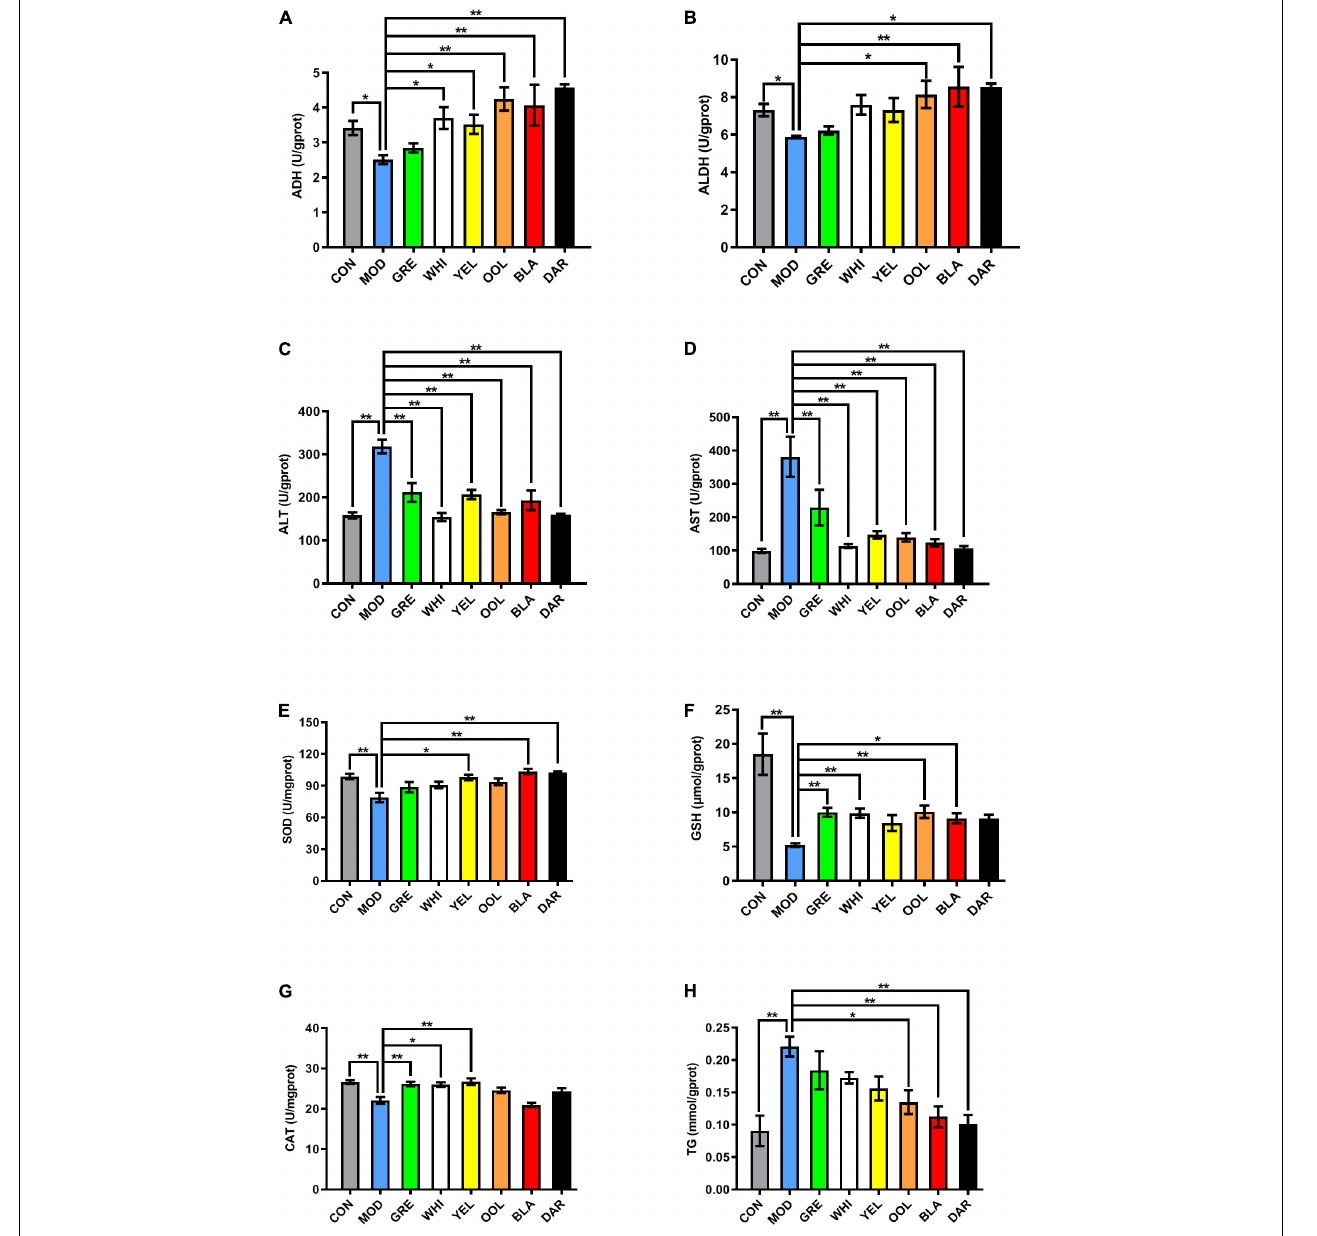
FIGURE 4 | Effect of WEATs treatment on ADH (A) , ALDH (B) , ALT (C) , AST (D) , SOD (E) , GSH (F) , CAT (G) , TG (H) and levels in the liver. Each value represents the mean ± SEM ( n = 10). * p < 0.05 vs. MOD; ** p < 0.01 vs. MOD.